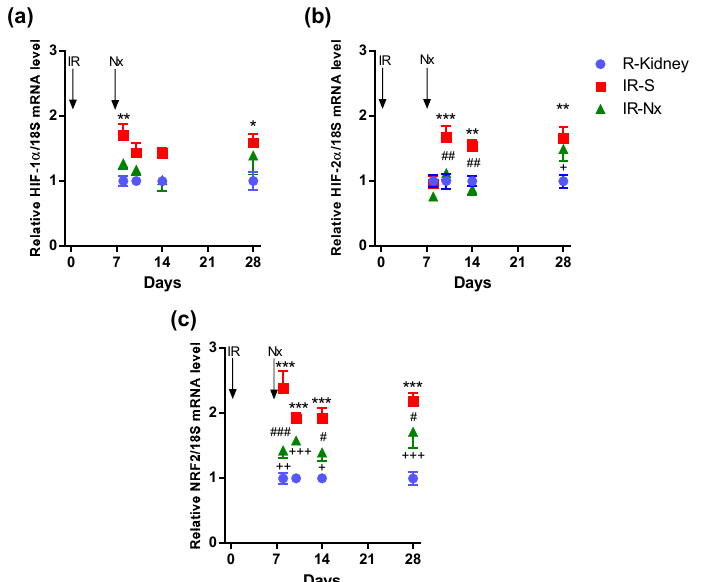
Figure 7. Fold changes in hypoxia- and oxidative stress-related mRNAs normalized to 18S. ( a ) HIF-1 α , ( b ) HIF-2 α and ( c ) nuclear factor erythroid 2-related factor 2 (NRF2). Data are expressed as mean ± SEM and two-way ANOVA with Tukey’s post hoc test. *: p < 0.05, **: p < 0.01 and ***: p < 0.001 IR-S (red) vs. nonischemic right kidneys (blue); + : p < 0.05, ++ : p < 0.01, +++ : p < 0.001 IR-Nx (green) vs. nonischemic right kidneys (blue), #: p < 0.05, ##: p < 0.01 and ###: p < 0.001 IR-S (red) vs. IR-Nx (green). Lipocalin-2 (Lcn-2, also named as NGAL, a tubular injury marker) was significantly elevated at all time points in postischemic IR-S kidneys (red) compared to the nonischemic right kidneys (blue) with two peaks at days 10 (130-fold) and 28 (120-fold), suggesting an ongoing tubular injury after IRI. Nx reduced Lcn-2 upregulation in IR-Nx (green) vs. IR-S kidneys (red) only on day 28. Lcn-2 remained elevated in the IR-Nx (green) vs. the nonischemic right kidneys (blue) (Figure 8a). Transforming growth factor-beta (TGF- β 1, one of the main drivers of fibrosis) mRNA was significantly elevated at all time points in postischemic IR-S kidneys (red) compared to the nonischemic right kidneys (blue). The maximum elevation was eight-fold on day 10 and declined thereafter but stayed significantly elevated at day 28. Nx significantly reduced TGF- β 1 upregulation in all IR-Nx (green) vs. IR-S kidneys (red). TGF- β 1 remained elevated in the IR-Nx (green) vs. the nonischemic right kidneys (blue) (Figure 8b). Alpha-smooth muscle actin ( α -SMA, a fibroblast marker) mRNA was significantly and similarly elevated at all time points in postischemic IR-S kidneys (red) compared to the nonischemic right kidneys (blue). The maximum elevation was eight-fold on day 14 and was similar on day 28. Nx significantly reduced α -SMA upregulation on days 14 and 28 in IR-Nx (green) vs. IR-S kidneys (red). Despite a significant reduction, α -SMA was stayed elevated at all time points in the IR-Nx (green) vs. the nonischemic right kidneys (blue) (Figure 8c). Collagen 1A1 (Col1a1, a main component of the fibrotic extracellular matrix) mRNA was elevated on day 8 and increased to day 28 in postischemic IR-S kidneys (red) compared to the nonischemic right kidneys (blue). The maximum elevation was 41-fold on day 28. Nx reversed Col1a1 upregulation to a progressively greater extent over time on days 10, 14 and 28 in IR-Nx (green) vs.